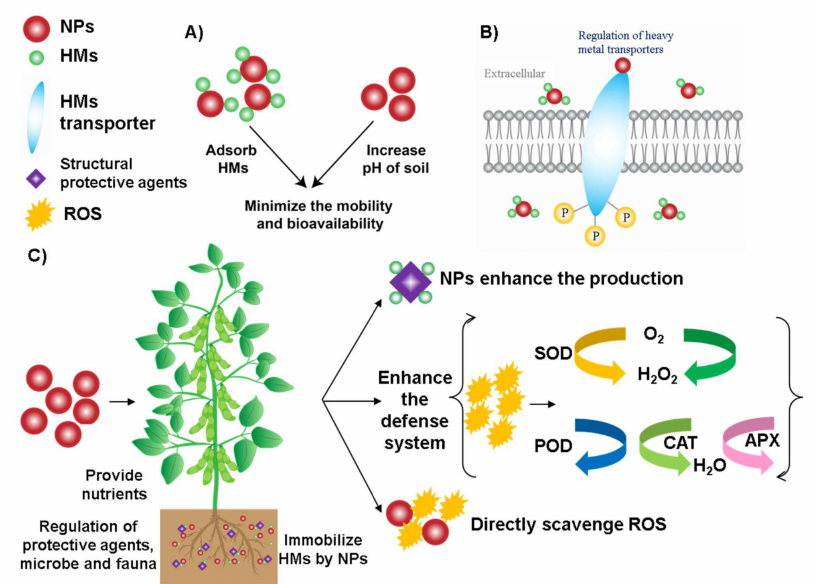
Figure 3. Mechanisms of NPs to alleviate HM stress in soil and plant tissues. ( A ) NPs increase the soil pH, adsorb HM, which minimize the mobility and bioavailability of HM. ( B ) NPs can enhance the defense ability of plants by regulating the HM transport genes. ( C ) NPs enhance the plant defense system, promote the production of protective agents and directly scavenge ROS, which ultimately improve the plant growth and nutritional content of